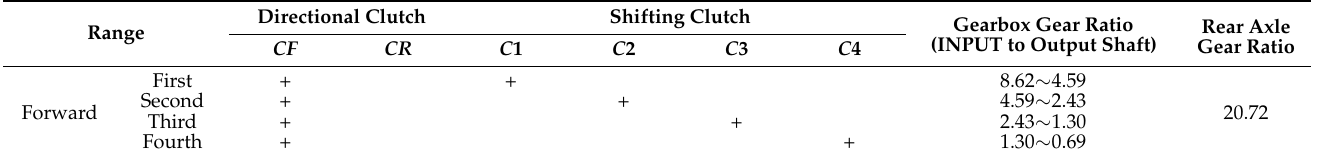
Table 1. Clutches’ engagement schedule for the HMCVT.